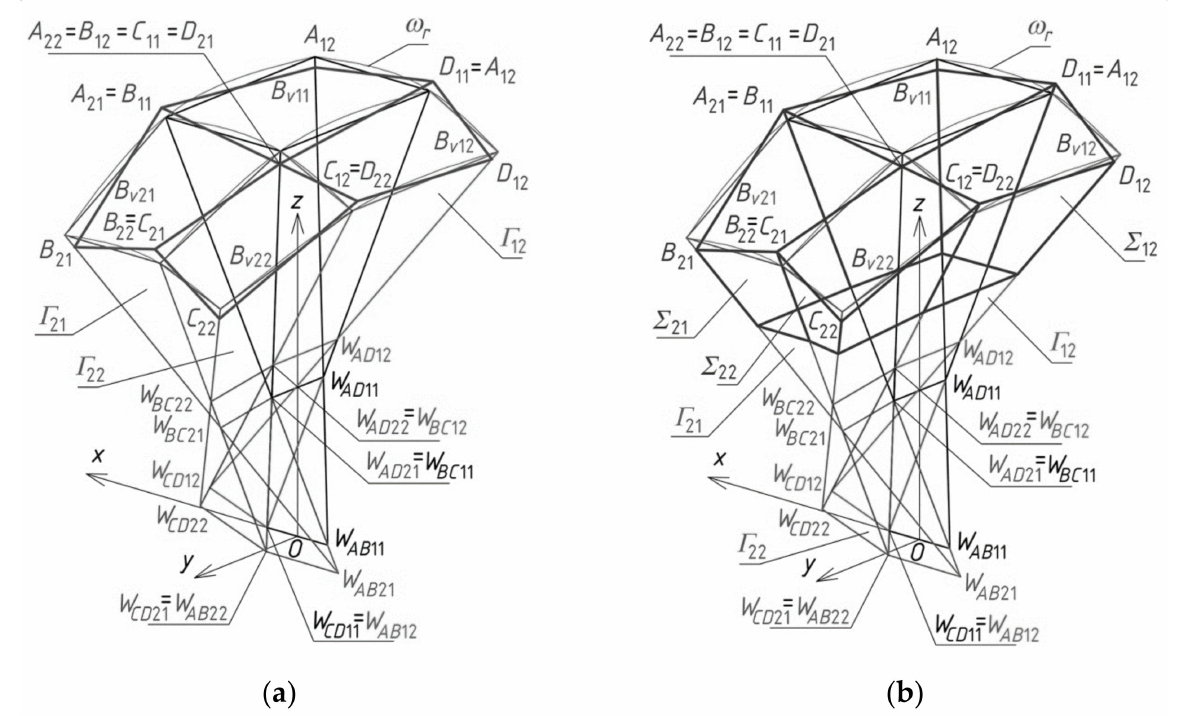
Figure 15. Final steps of creating: ( a ) B v net; ( b ) elevation structure ∑ . Four vertices A 21 , B 21 , C 21 and D 21 of the eaves B v 21 have to be determined on the side edges a 21 , b 21 , c 21 and d 21 of Γ 21 in accordance with ω r (Figure 15a). Two of these vertices are A 21 = B 11 , D 21 = C 11 . The other two C 21 and B 21 have to be determined on two side edges c 21 ( W BC 21 , W CD 21 ) and b 21 ( W AB 21 , W BC 21 ), using two division coefficients constituting two elements of the third set of the initial data. The points A i 1 , B i 1 , C i 1 and D i 1 belonging